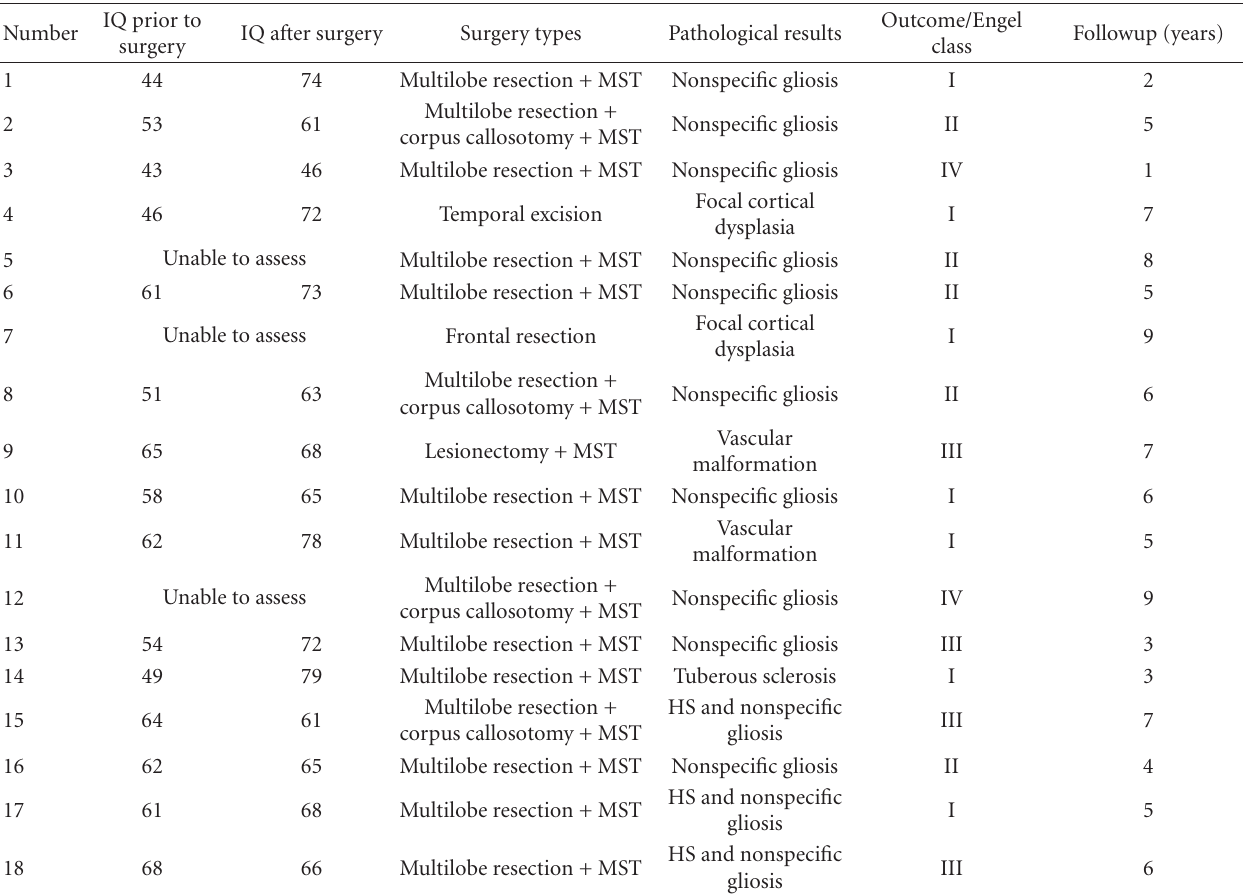
Table 2: Patient profiles—number 2.